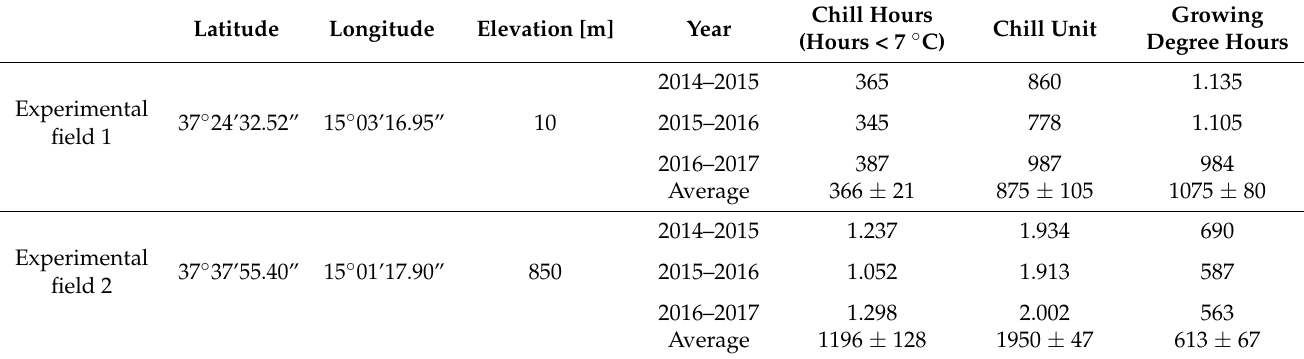
Table 1. Geolocations and yearly and average data related to the Chill Hours, Chill Units (from 1 October to 28 February) and Growing Degree Hours (from 1 March to 30 June) ( ± standard deviation) calculated from data of the years 2014–2017 in the experimental field 1 (10 m above sea level) and experimental field 2 (850 m above sea level). Climatic data were provided by the Sicilian Water Observatory (www.osservatorioacque.it (accessed on April 2019) . Chill Hours Latitude Longitude Elevation [m] Year Chill Unit (Hours < 7 ◦ C)